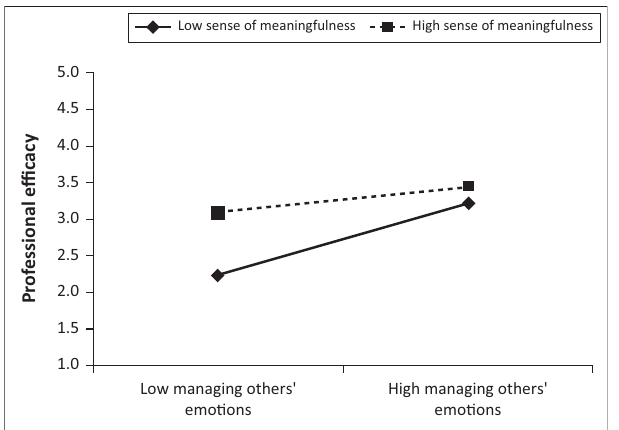
1.01.52.02.53.03.54.04.55.0